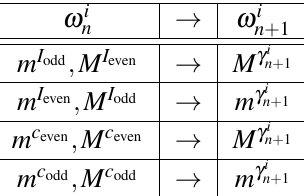
Table 2 Transition rules for l -modal maps with a negative